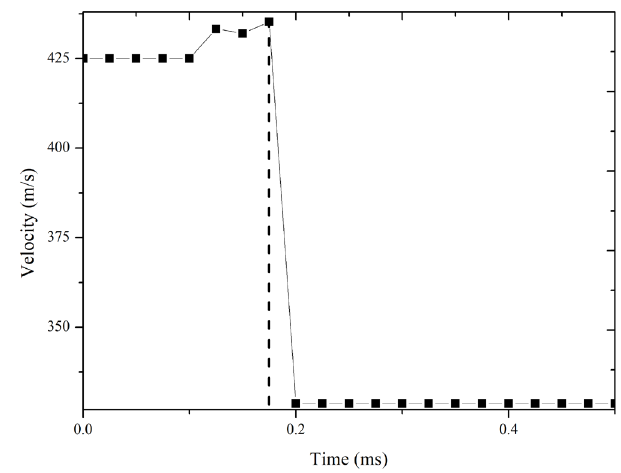
Figure 5. AMMO 1 specific velocity for each time step graph.